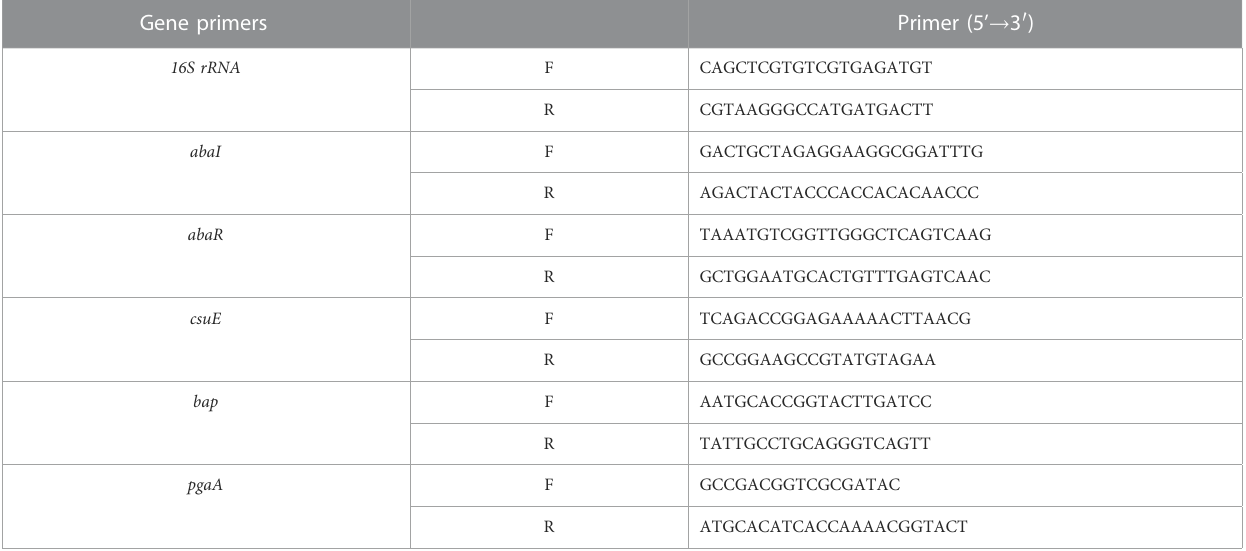
TABLE 1 Primer sequence. Gene primers Primer (5 ’ → 3 ′ )